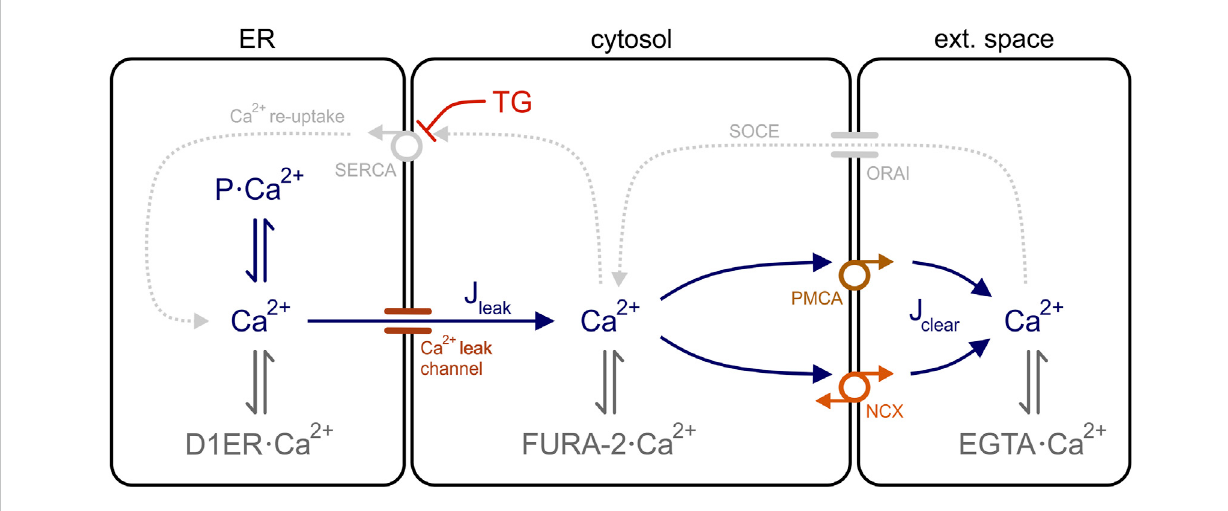
FIGURE 5 Model of the Ca 2+ dynamics in HEK-293 cells. Three cell compartments are depicted in the model: ER, cytosol, and extracellular space. In the ER, freeCa 2+ isinequilibriumwithCa 2+ boundtotheERCa 2+ sensorD1ER(D1ER · Ca 2+ )andtoluminalERbindingproteins(P · Ca 2+ ),suchascalreticulinandBiP. For simplicity, Ca 2+ binds only to the Ca 2+ sensor FURA-2 (FURA-2 · Ca 2+ ) and to the chelator EGTA (EGTA · Ca 2+ ) in the cytosol an extracellular space, respectively. Ca 2+ ions fl ow out of the ER through leak channels (J leak ) and are removed from the cytosol via clearance mechanisms (J clear ). In the presence of thapsigargin (TG), SERCA pumps are blocked and the Ca 2+ re-uptake into the ER (Ca 2+ re-uptake) is interrupted. The store-operated Ca 2+ entry (SOCE) into the cells is also disrupted because Ca 2+ is chelated in the external solution with EGTA. PMCA, plasma membrane Ca 2+ ATPase;